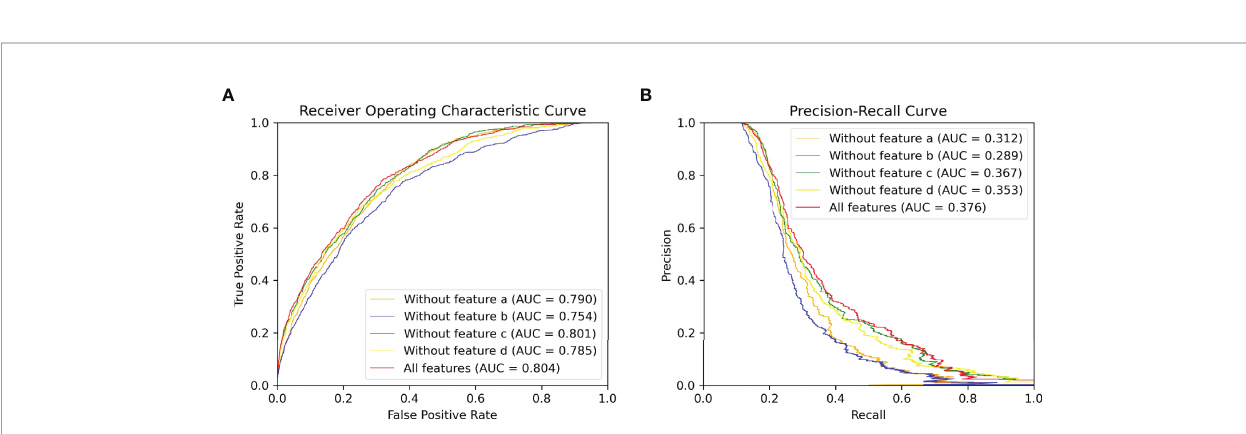
FIGURE 5 | ROC and PR curve of different combinations of input features among all antigen residues in the testing set. (A) ROC curve. (B) PR curve.